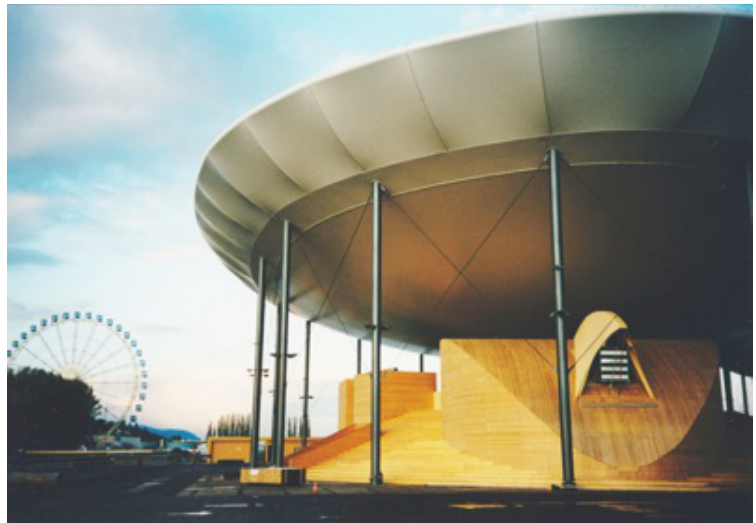
Figure 21. Interactive multimedia installation, Pinocchio’s Square , exhibited at the Expo in 2002 in Neuchâtel, Switzerland, from May to October 2002. Rear view of the massive wooden structure that housed the installations inspired by Pinocchio’s